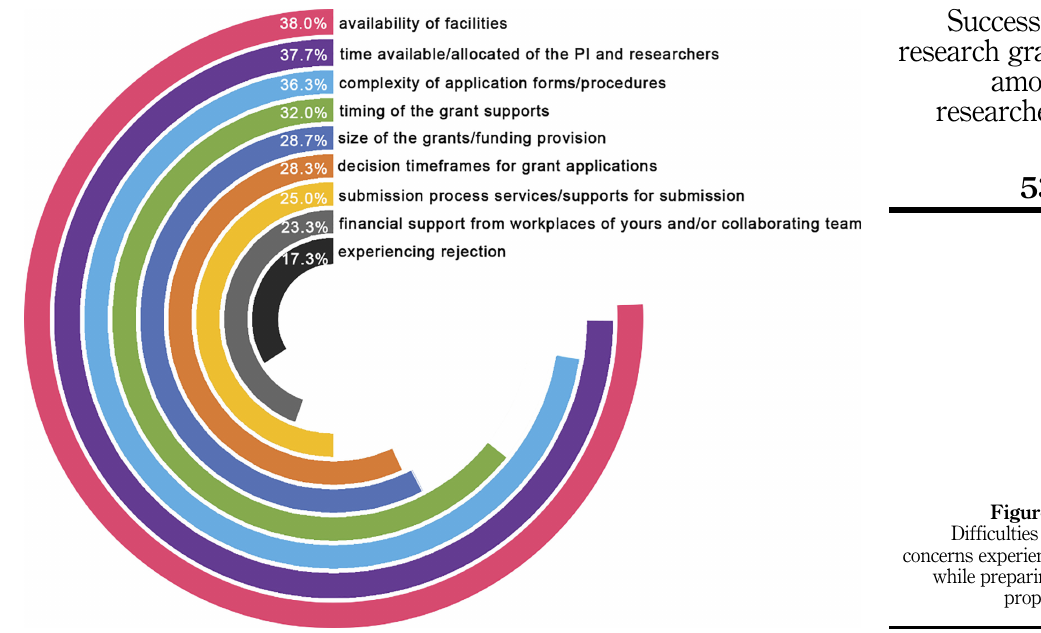
Figure 2. Difficulties and concerns experienced while preparing a